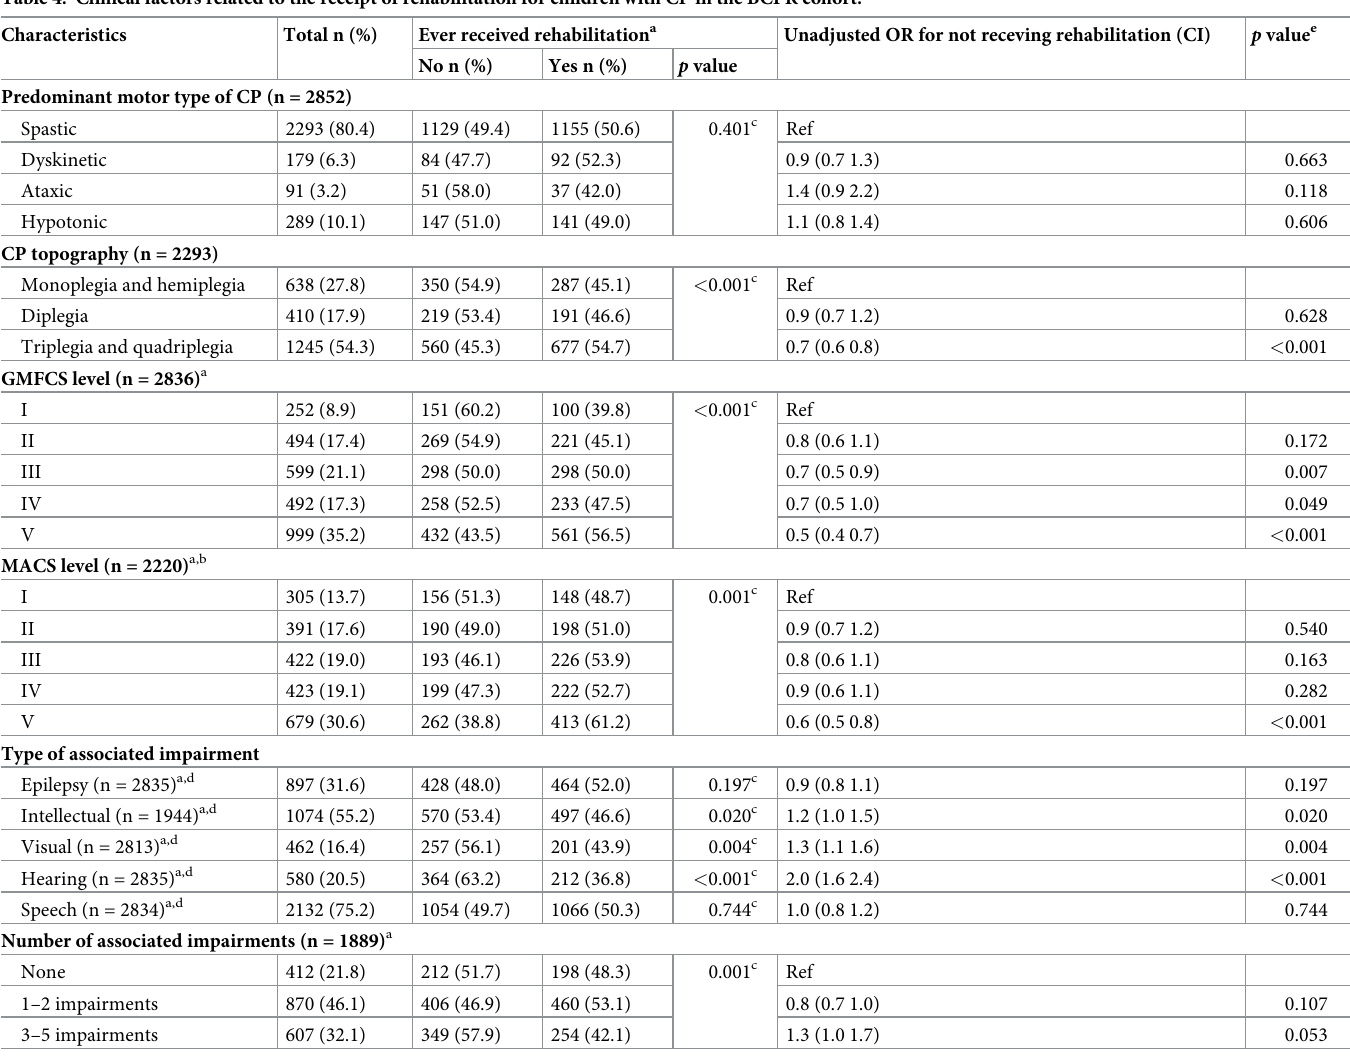
Table 4. Clinical factors related to the receipt of rehabilitation for children with CP in the BCPR cohort.